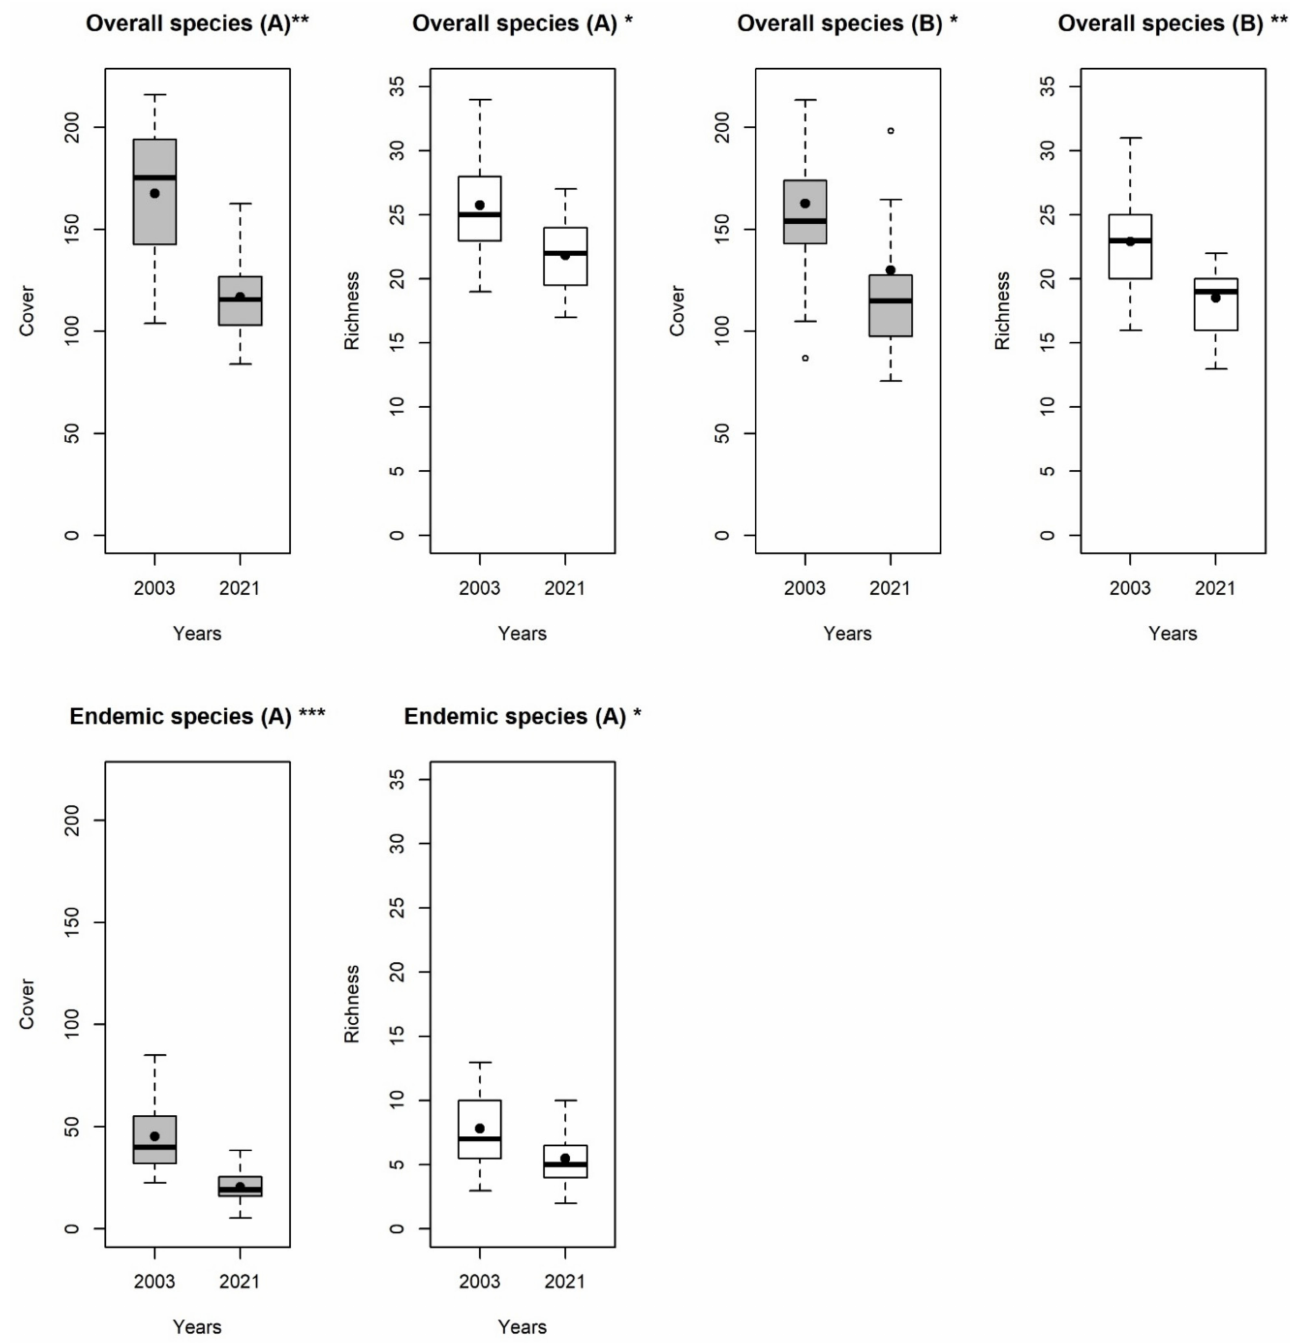
Figure 3. Boxplot comparing cover (grey) and species richness per 4 × 4 m plot (white) of overall and endemic species in two time steps (T1: 2003 and T2: 2021) in Apennine stripped grasslands (A) and wind edge swards (B). Only the significant results are reported. Asterisks indicate significant differences according to the Kruskal–Wallis test for equal medians (* p < 0.05, ** p < 0.01, *** p <